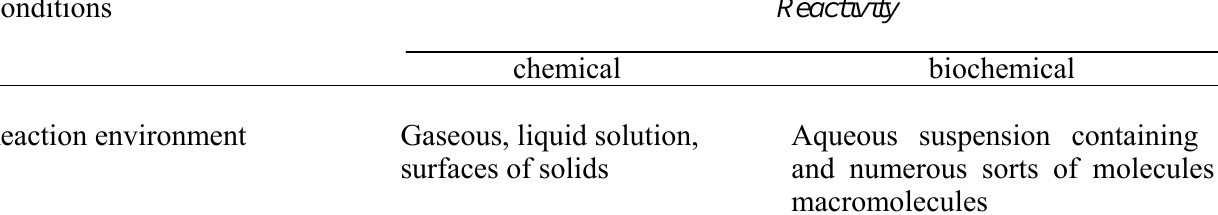
Table 1 . Characteristics of Chemical and Biochemical Reactivity. a